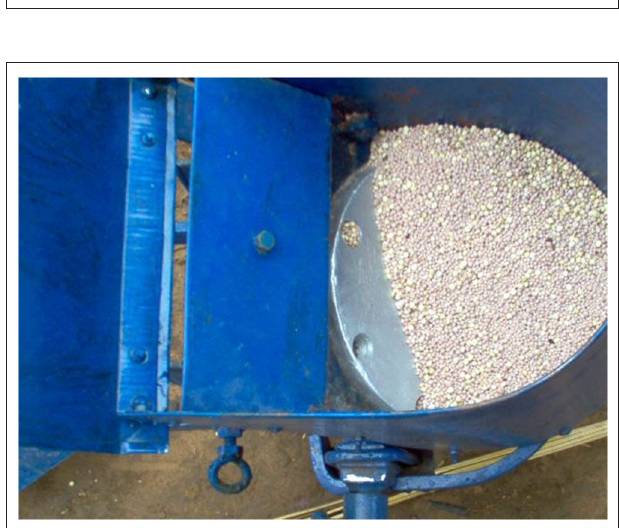
FIGURE 2 | The seed/fertilizer is applied by the turning disc inside the hopper of the planter.